Question: What does this figure show? Answer in one sentence.
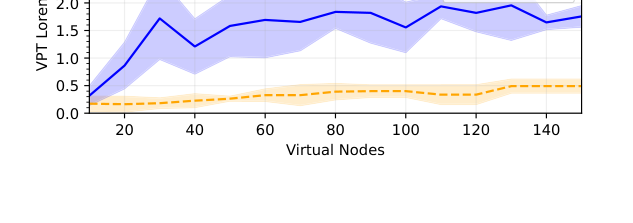
Answer: (a) NRMSE, (b) VPT for UCTLS, and (c) VPT for ALRS for classical linear regression (dashed orange line) and attention- enhanced reservoir computing (solid blue line) with varying coupling strength reservoir sizes N. The shaded areas depict the standard de- viations of NRMSE and VPT over ten time series.